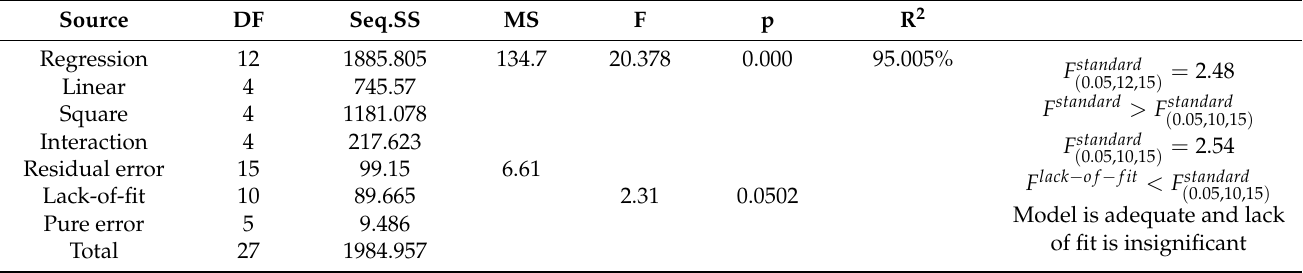
Table 6. Analysis of variance (ANOVA) for the obtained Equation (4) without insignificant